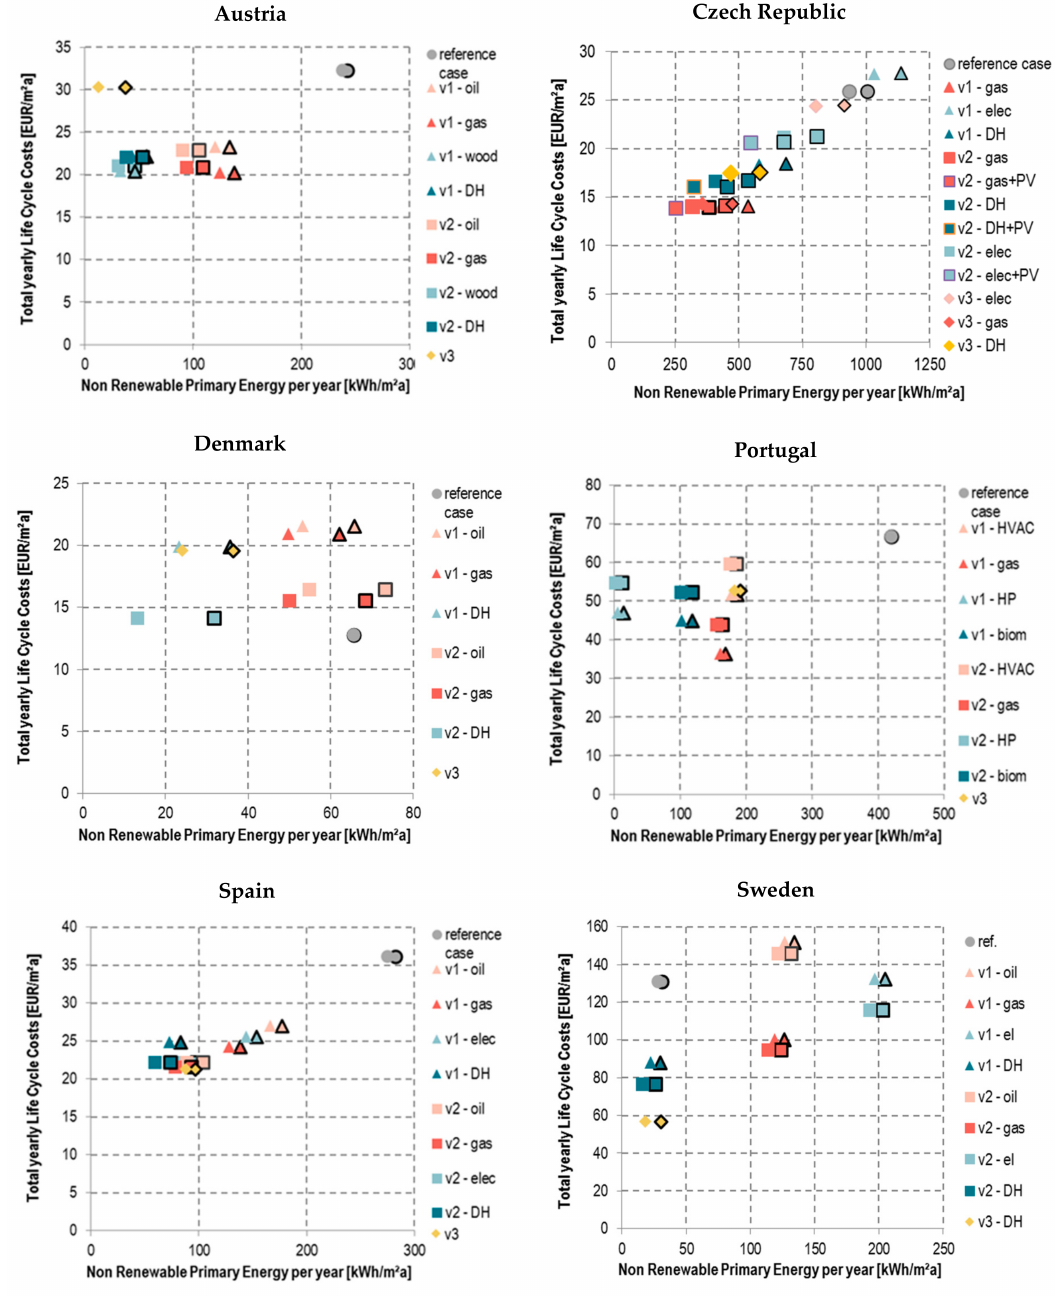
Figure 5. Comparison of calculations for non-renewable primary energy for the six case studies, without including embodied primary energy and with embodied primary energy (marked with a black outline) for the different renovation